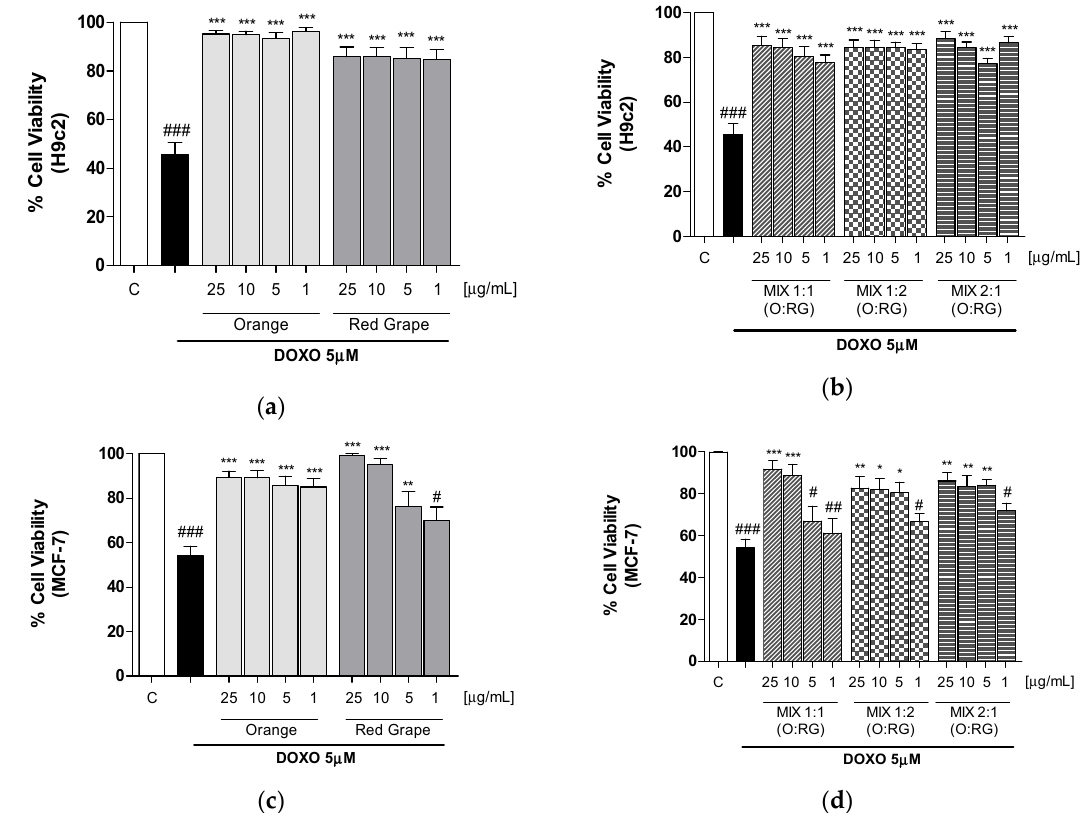
Figure 2. Effect of orange and red grapes extracts, and the 3 relative mixtures (1–25 μ g/mL) in combination with DOXO (5 μ M) on viability of H9c2 ( a , b ) and MCF-7 ( c , d ) cells, evaluated by MTT assay. Data are expressed as mean ± S.E.M. of % of cell viability. ***, ** and * denote respectively p < 0.001, p < 0.01 and p < 0.05 vs DOXO alone. ###, ## and # denote respectively p < 0.001, p < 0.01, and p < 0.05 vs C.